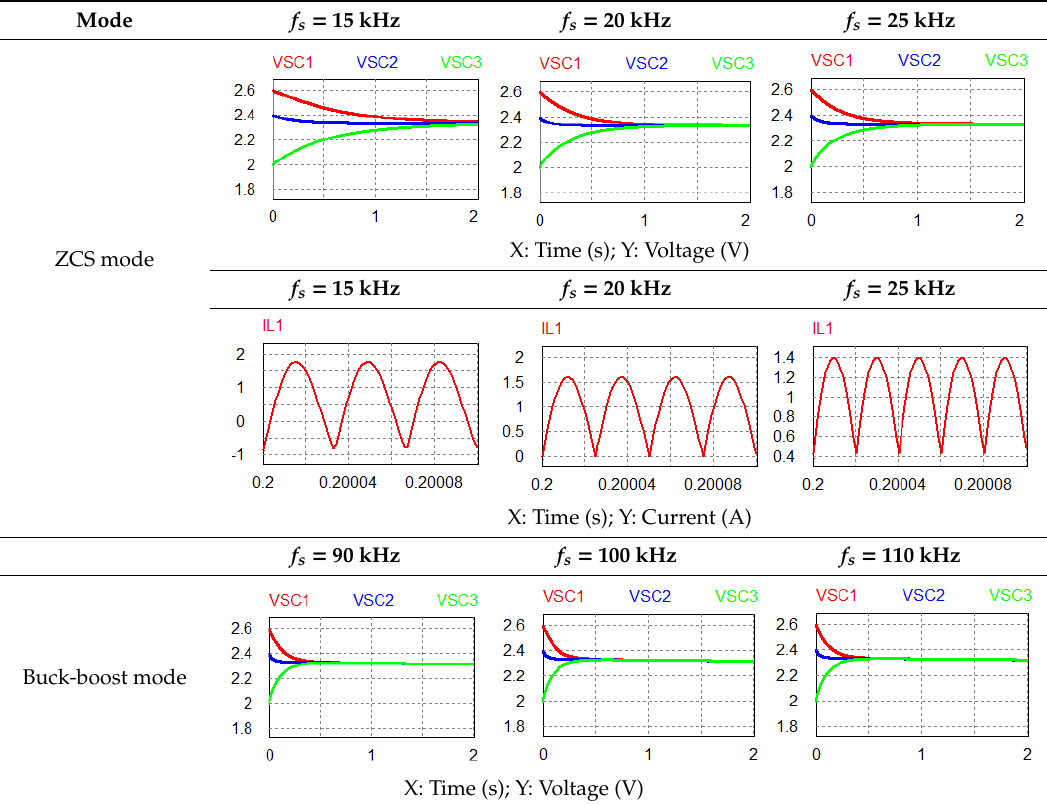
Table 2. Simulation results of the switched-capacitor voltage equalizer.